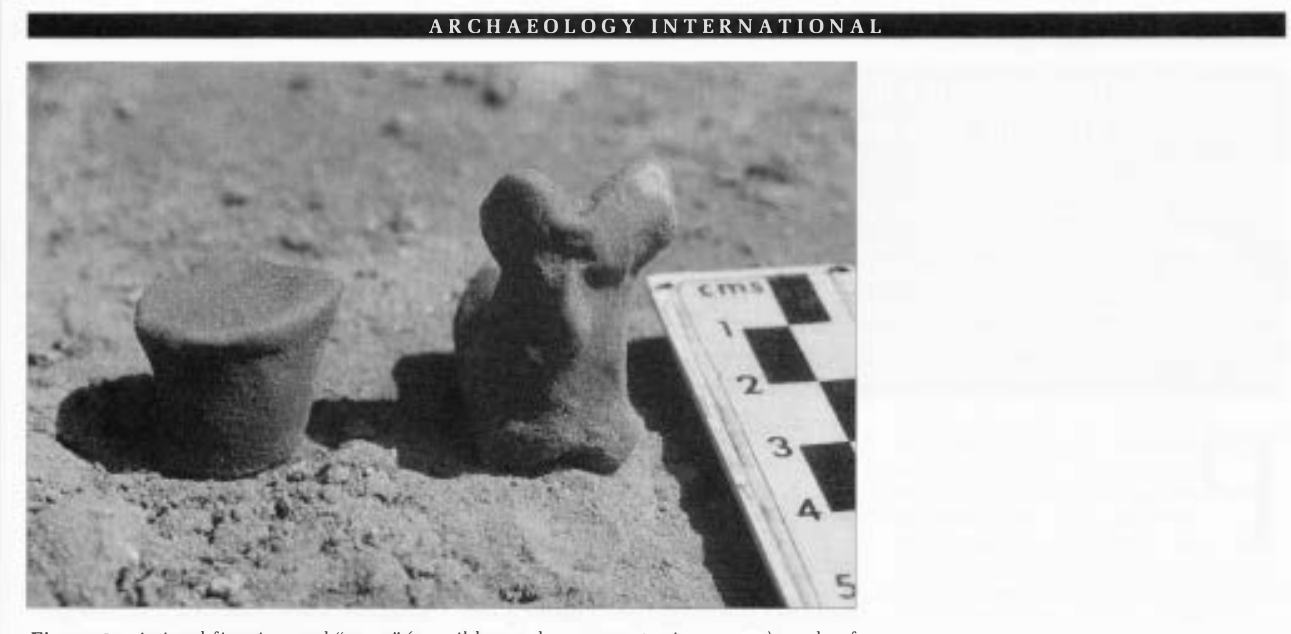
Figure 6 Animal figurine and "cone" (possibly used as a counter in a game) made of baked clay; excavated at feitun in 1 993. Notes 1. Cordon Childe first alluded to the